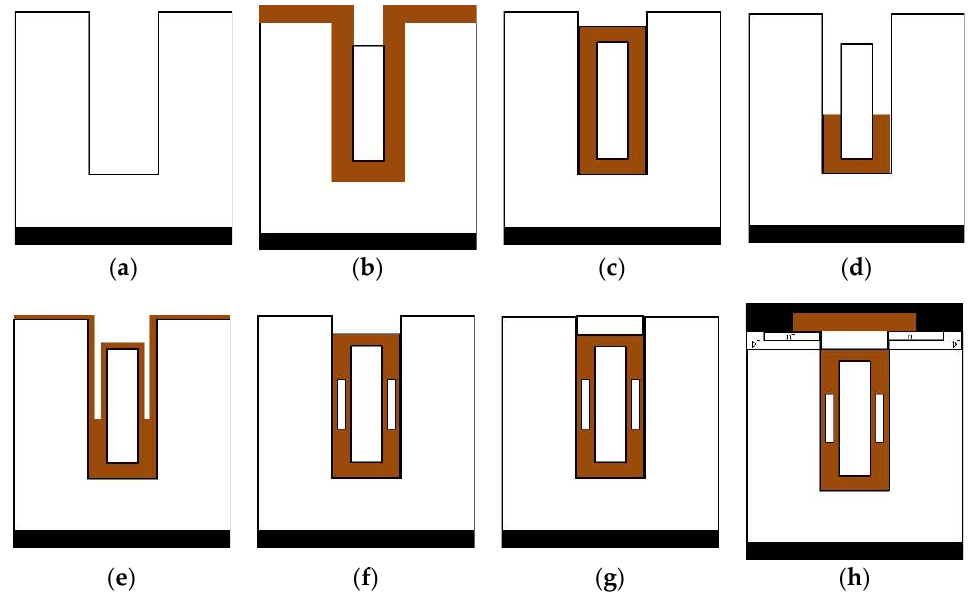
Figure 5. Proposed fabrication process steps for the DFSGRSO UMOSFET.